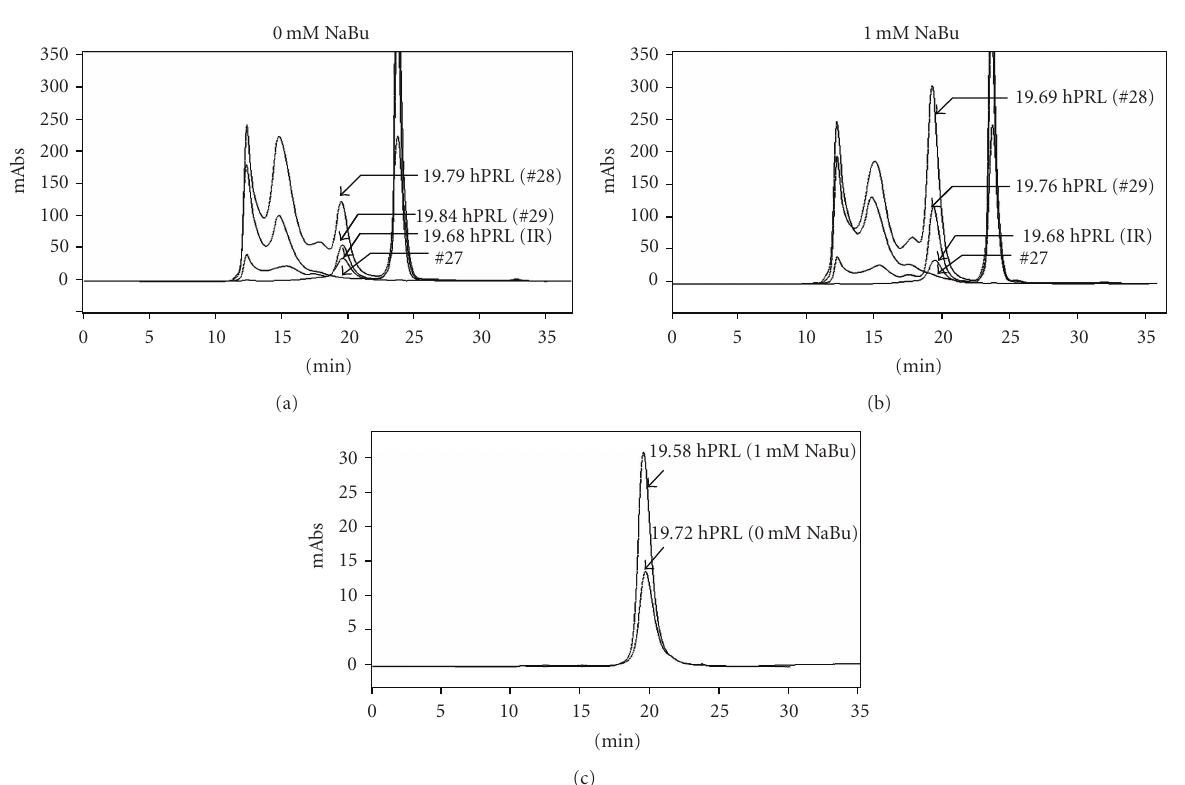
Figure 7: (a) and (b) Qualitative and quantitative HPSEC analysis of NaBu-treated and untreated CHO-derived hPRL after SP-Sepharose Fast Flow and (c) after preparative HPSEC purification, comparing the product obtained from tube #28 of nontreated (a) and NaBu-treated cells (b). IR: Internal Reference of periplasmic E. coli- derived hPRL (7.0 μ g). mAbs: milliabsorbance. Tube numbers (#27, #28, and #29) are from SP-Sepharose chromatography. Retention Times ( t R ) are